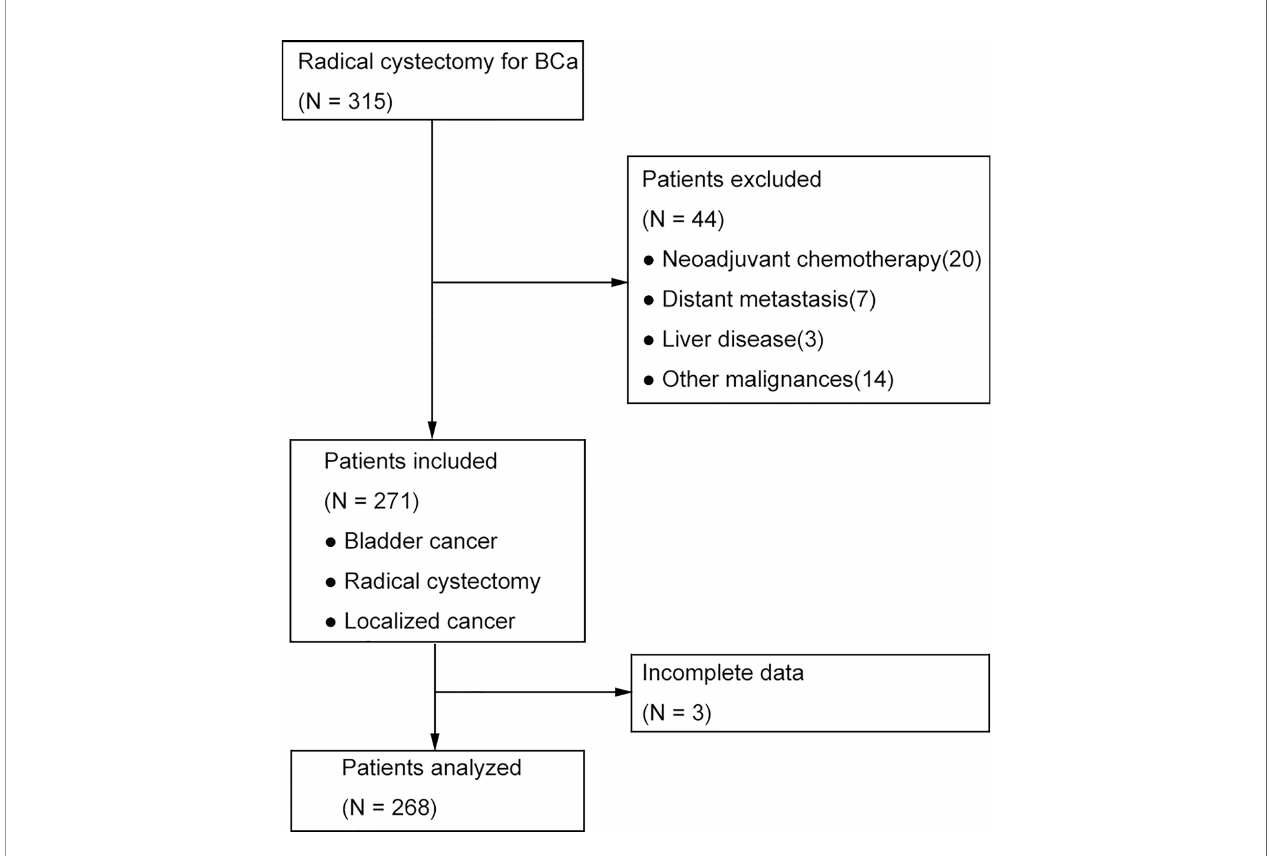
FIGURE 1 | The fl ow chart for patient